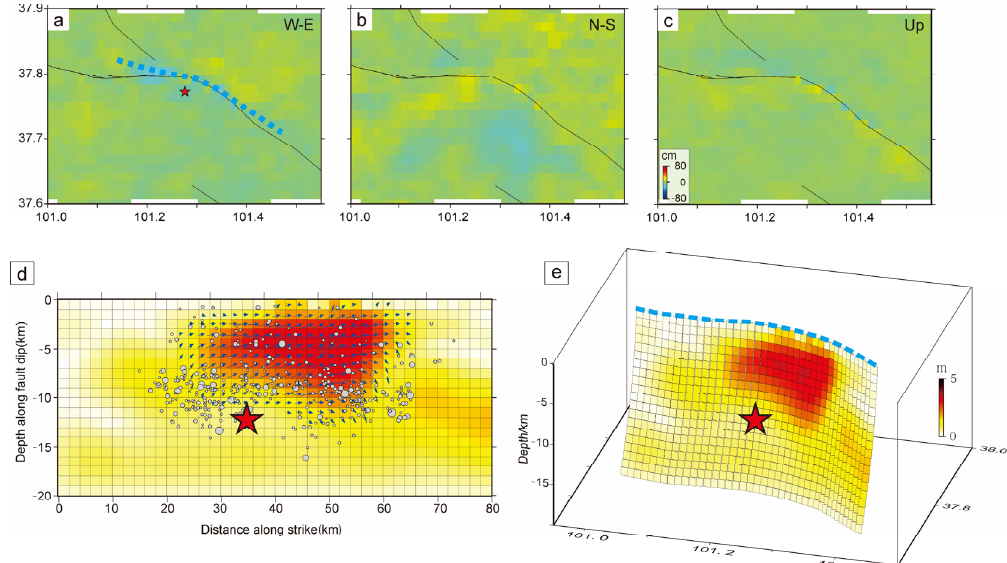
Figure 6. Inversion of the co-seismic slip distribution of the 2022 Menyuan earthquake. ( a – c ) Distribution maps of the residuals in the east-west direction, north-south direction, and vertical direction. ( d , e ) Two- and three-dimensional views of the co-seismic fault slip distribution of the earthquake.